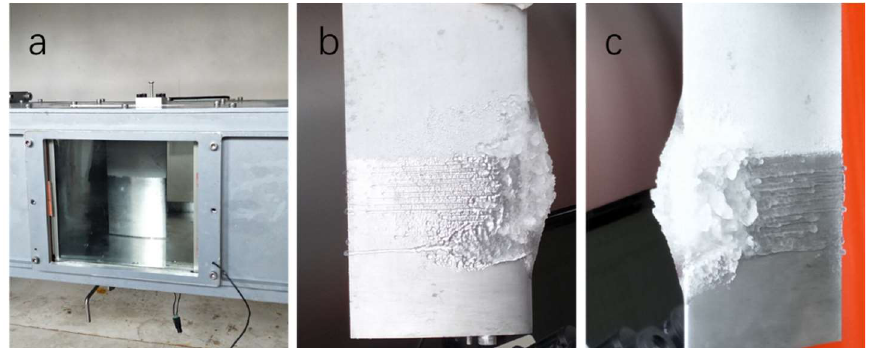
Table 2. WCA of SiO 2 /RF-608 composite before and after abrasion.